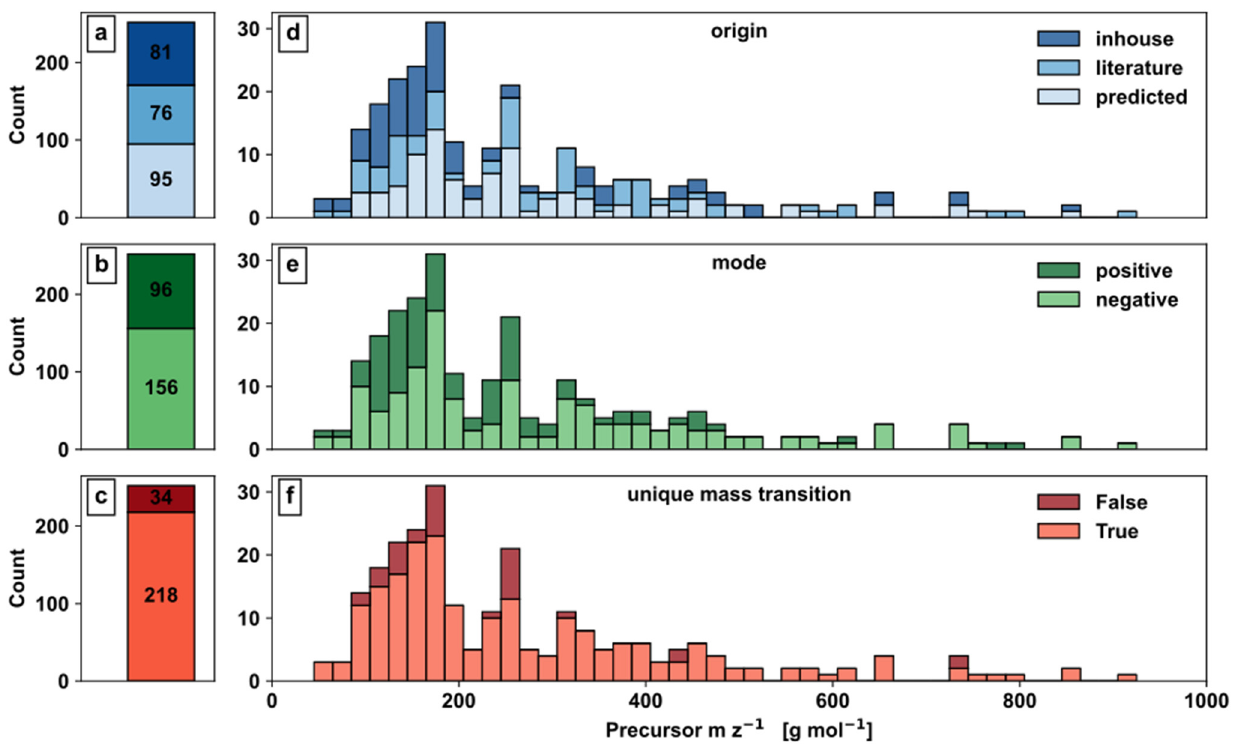
Figure 4. Automated method development: Barplots ( a – c ) and Histograms ( d – f ) for SCE development; ( a , d ) Origin information of mass transitions; ( b , e ) Mode information based on pK a value; ( c , f ) Mass transition convolution.